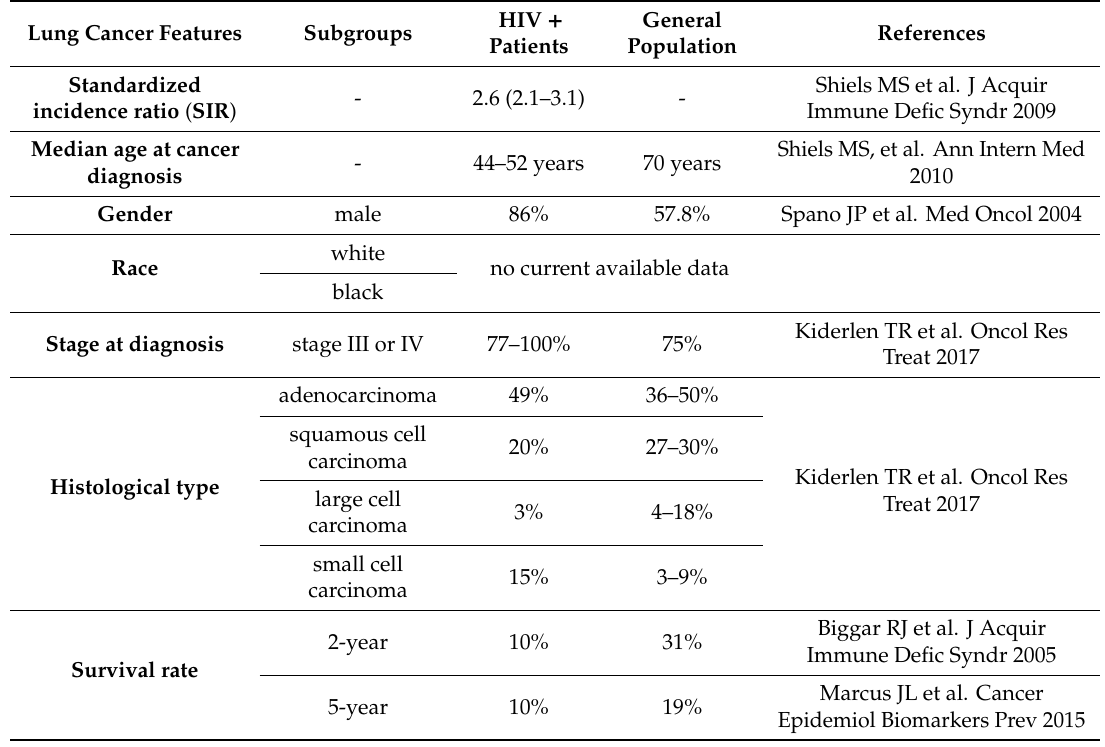
Table 1. Epidemiology, clinical–pathological characteristics and prognosis of lung cancer in HIV positive people compared to the general population. The table represents in summary those current available data about lung cancer epidemiology, features and prognosis that may di ff er between HIV-infected and uninfected individuals. HIV seems to have a prognostic value, meanwhile no clear di ff erence by HIV-status emerges in terms of e ffi cacy of oncologic treatments (see the